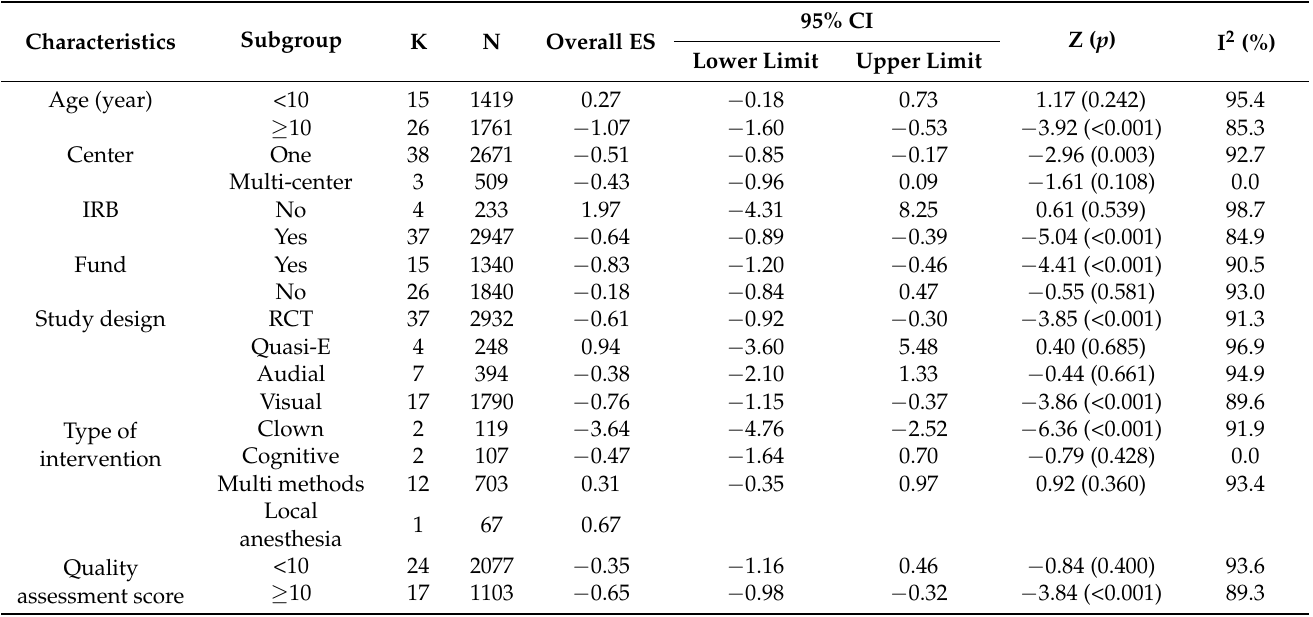
Table 2. The subgroup analysis of the effect of distract intervention on needle-related pain of the child by the study characteristics (N =